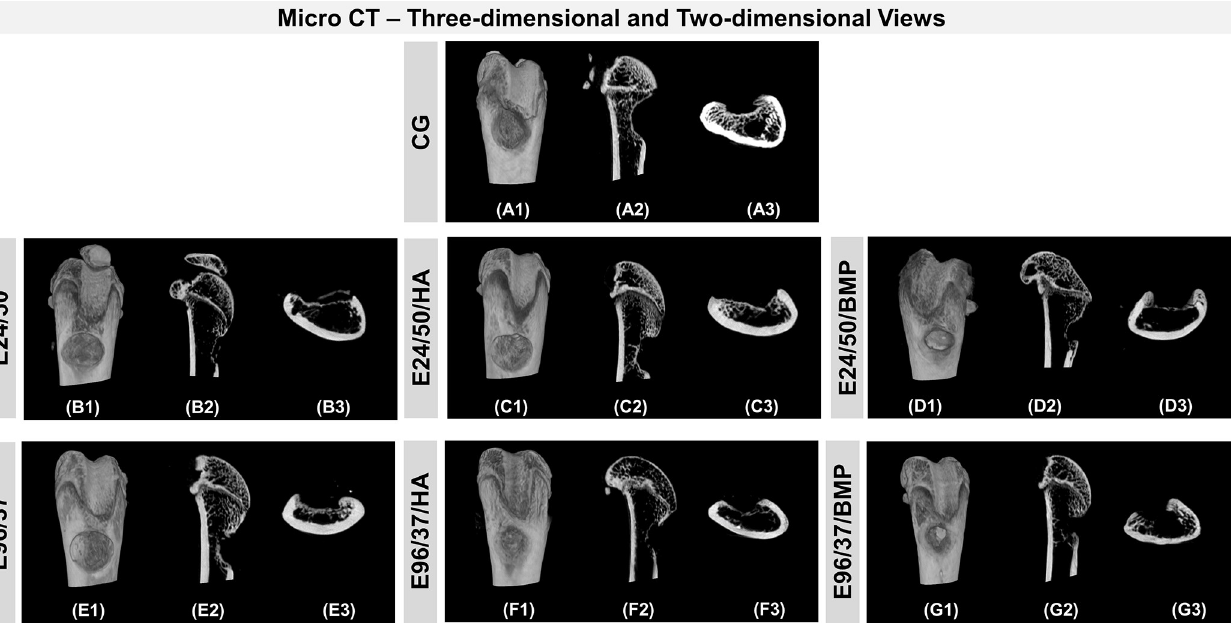
Fig 5. Micro CT assessments. A) Three-dimensional reconstruction area: shows metaphyseal defects of the distal femur of the CG mice (unfilled), and groups filled with E24/50, E24/50/HA, E24/50/BMP, E96/37, E96/37/HA and E96/37/ BMP (A1-G1, respectively). B) Two-dimensional view: Representative sagittal (A2-G2) and transaxial (A3-G3) reconstruction images obtained by the micro-CT analysis of femoral rat bone from the CG, E24/50, E24/50/HA, E24/50/BMP, E96/37, E96/37/HA and E96/37/BMP